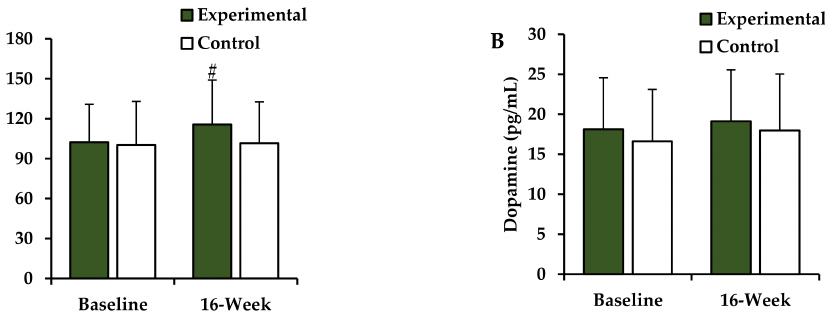
Figure 2. Changes in plasma neurotransmitters. Values are presented as mean ± SD. ( A ) serotonin; ( B ) dopamine; # Compared with baseline values within the experimental group ( p < 0.05).